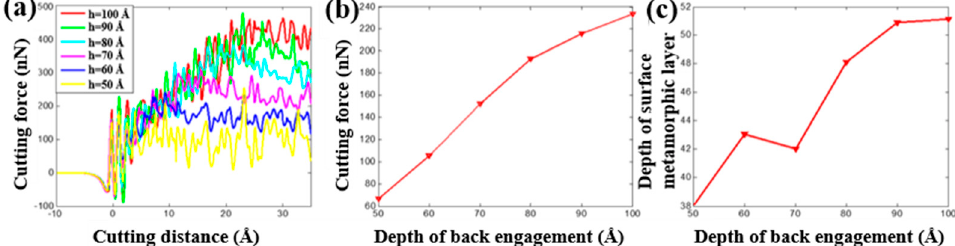
Figure 6. The cutting force and depth of metamorphic layer obtained from MD by varying the depth of back-engagement. ( a ) Cutting force vs. the cutting distance under different back-engagement h; ( b ) evolution of the average cutting force when varying the depth of back-engagement and ( c ) evolution of the depth of the surface metamorphic layer when varying the depth of back-engagement.